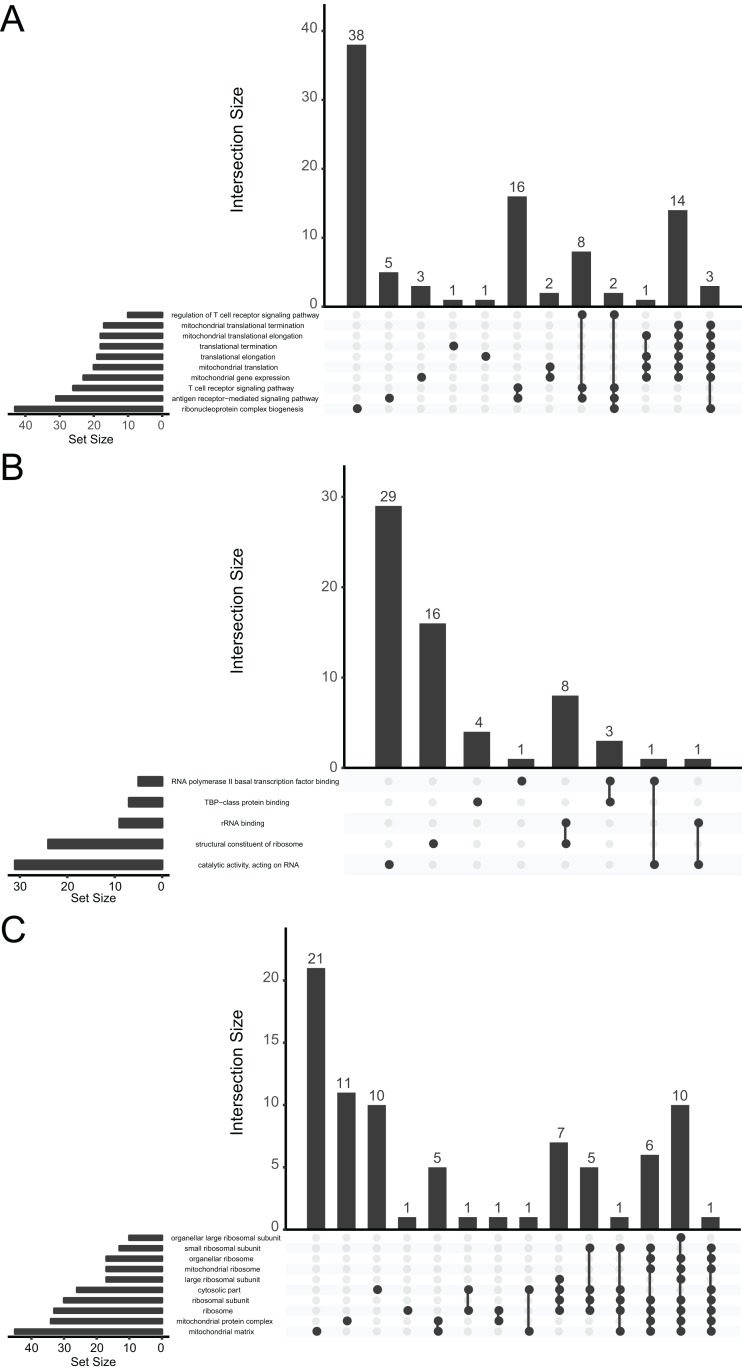
UpSetR plot demonstrating distribution of the gene ontology annotations for major depressive disorder in (A) biological processes, (B) molecular functions, and (C) cellular components.